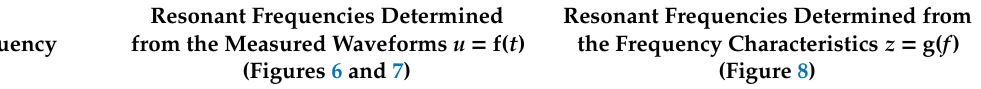
Table 5. The frequencies f 0 , f 1 , and f 2 (Figure 2) of oscillating components of overvoltage waveforms at the terminals of a transformer switched o ff with a vacuum circuit breaker determined on the basis of impedance characteristics